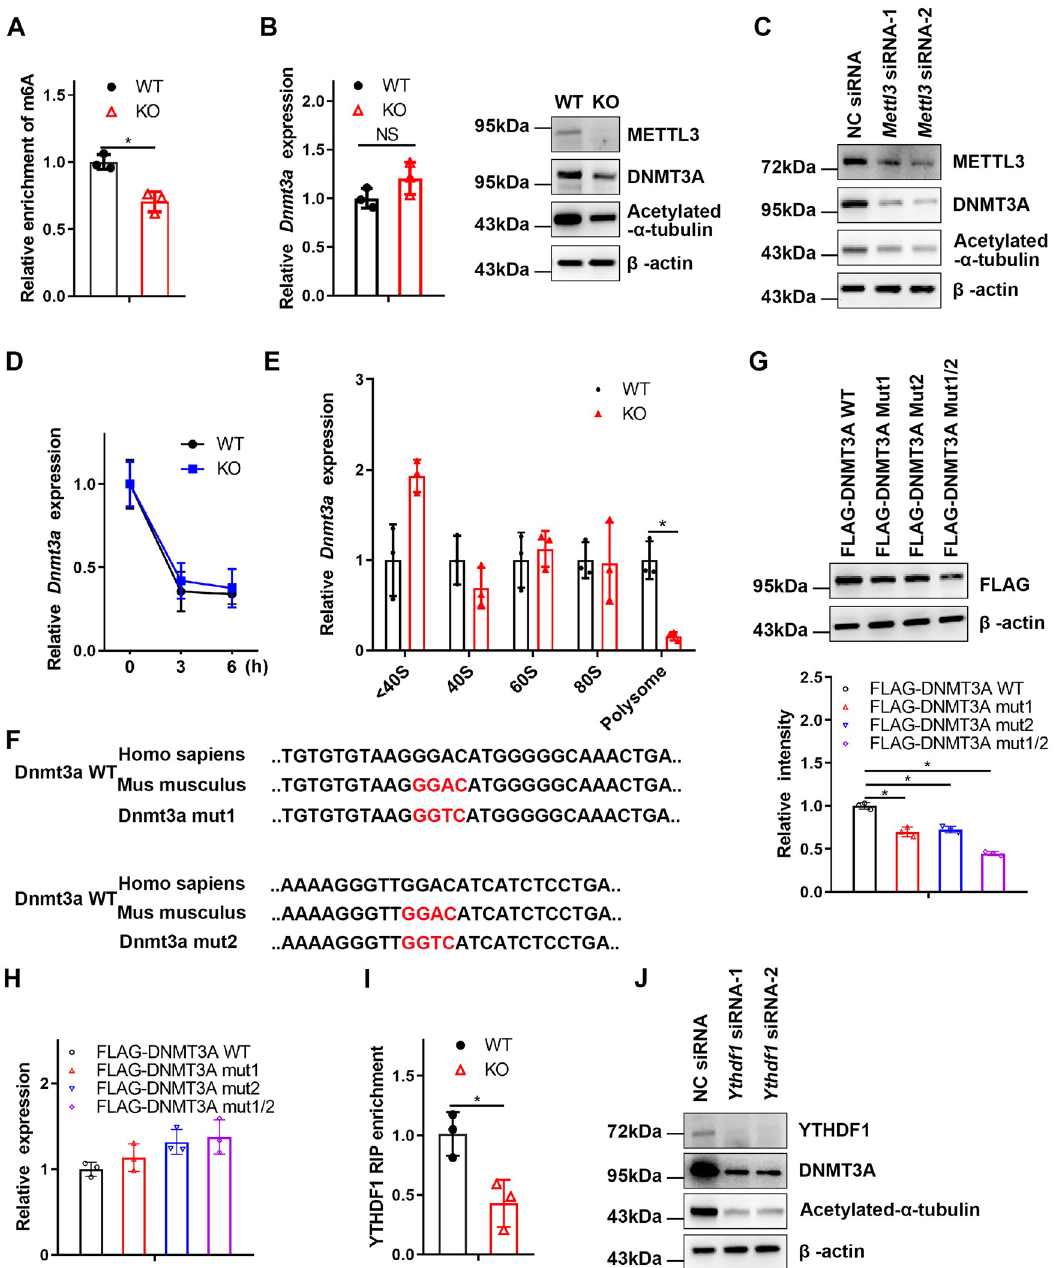
Fig 4. METTL3 facilitates DNMT3A translation mediated by YTHDF1. (A) MeRIP-qPCR analysis of Dnmt3a expression in WT and KO BMDMs. (B) qRT-PCR and western blotting analysis of DNMT3A levels in the WT and KO BMDMs. (C) Immunoblotting analysis of the indicated proteins in the BMDMs transfected with NC siRNA or Mettl3 siRNA. (D) Dnmt3a mRNA decay assay in the WT and KO BMDMs after actinomycin D treatment. (E) Analysis of Dnmt3a mRNA in non-ribosome portion ( < 40S), 40S, 60S, 80S, and polysome. (F) Schematic representation of mutations of the conserved m6A site in Dnmt3a mRNA. (G) The expression of DNMT3A WT, DNMT3A mut1, DNMT3A mut2, and DNMT3A mut1/2 was measured by western blots. The normalized intensity of DNMT3A WT, DNMT3A mut1, DNMT3A mut2, and DNMT3A mut1/2 was quantified. (H) qRT-PCR analysis of the expression of DNMT3A WT, DNMT3A mut1, DNMT3A mut2, and DNMT3A mut1/2. (I) Binding of YTHDF1 with Dnmt3a mRNAs in the WT or KO BMDMs was analyzed by YTHDF1 RIP-qPCR. (J) Immunoblotting analysis of the indicated proteins in the BMDMs transfected with NC siRNA or Ythdf1 siRNA. All data in the figure are shown as the mean ± SD. P < 0.05 ( � ). NS indicates no significant difference. Underlying data can be found in S1 Data. BMDM, bone marrow-derived macrophage; KO, knockout; MeRIP- qPCR, methylated RNA immunoprecipitation-qPCR; NC, negative control; qRT-PCR, quantitative reverse transcription PCR; RIP- qPCR, RNA immunoprecipitation PCR; WT, wild type.